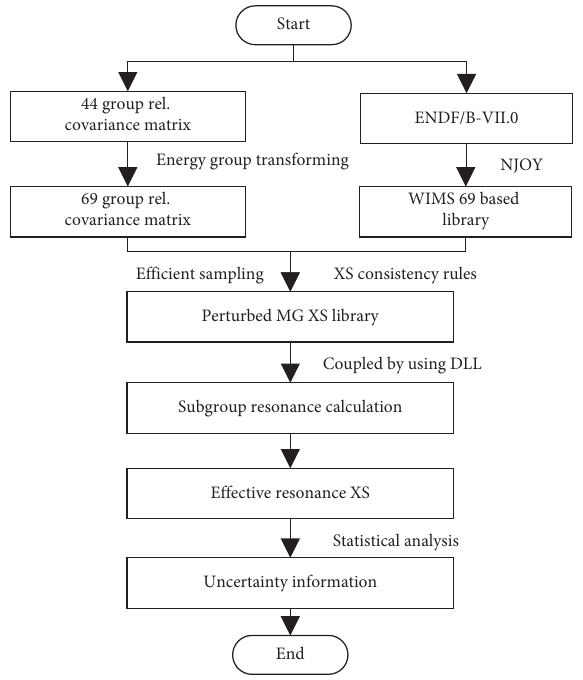
Figure 4: Flowchart of uncertainty analysis of effective resonance self-shielding XS by